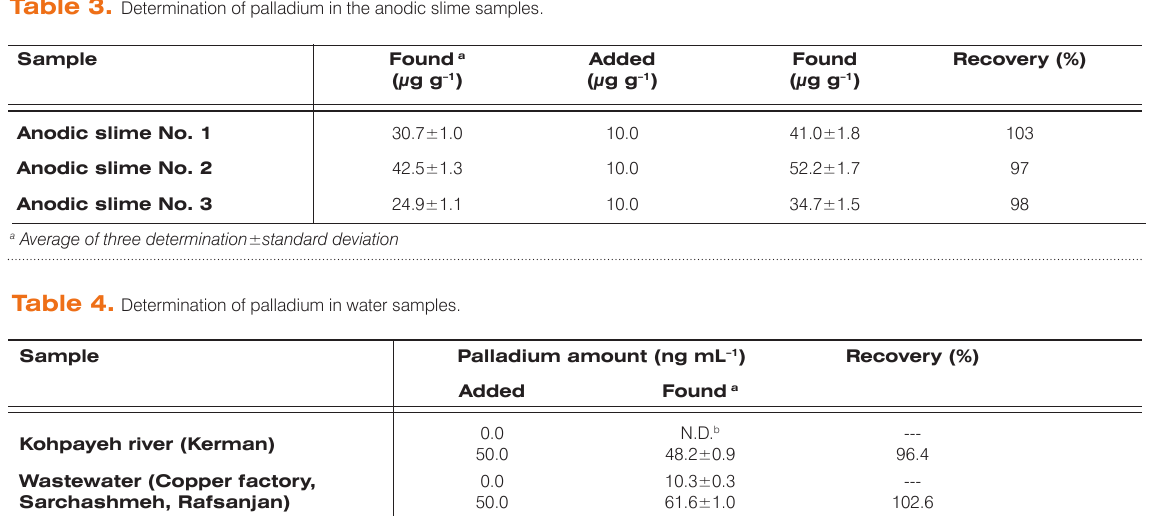
Table 3. Determination of palladium in the anodic slime samples.